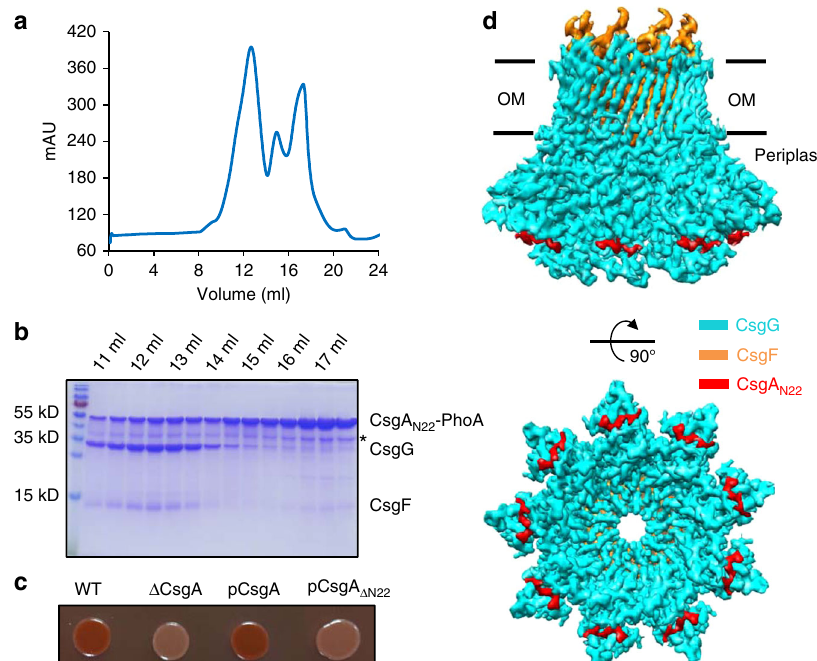
Fig. 4 CsgA N22 binding to CsgFG channel. a Size-exclusion chromatogram of the puri fi ed CsgFG and CsgA N22 -PhoA complex. b SDS-PAGE analysis and Coomassie blue staining of the puri fi ed CsgFG and CsgA N22 -PhoA complex from SEC. * Indicates PhoA degradation. Source data are provided as a Source Data fi le. c Congo red secretion assay for CsgA N22 truncation mutant. Source data are provided as a Source Data fi le. d Side (top) and top (bottom) view of the CsgFG-CsgA N22 complex structure. CsgG, CsgF, and CsgA N22 are in cyan, orange and red, respectively. OM outer membrane.